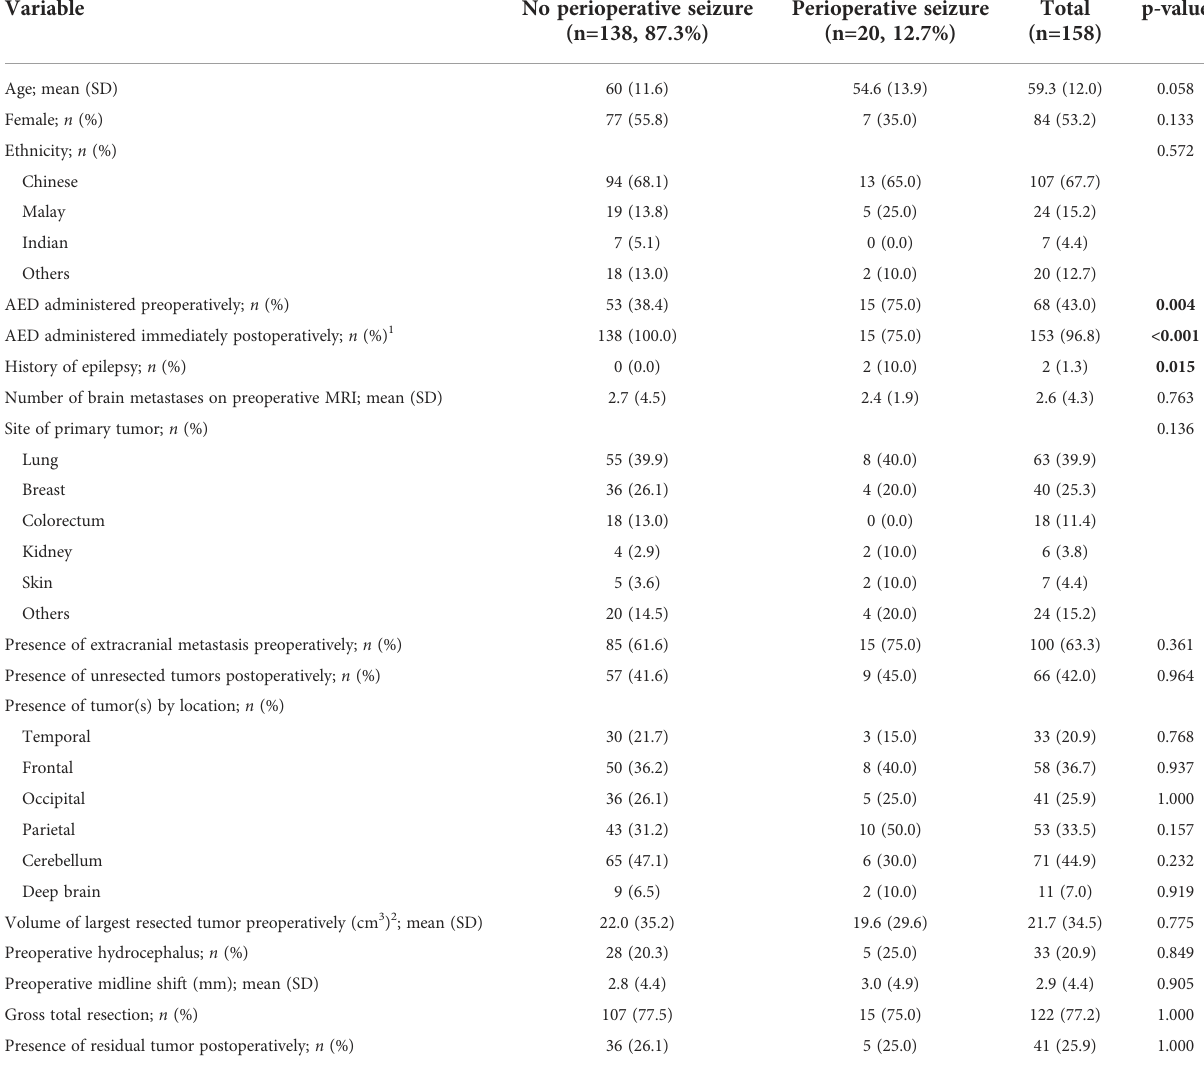
TABLE 1 Baseline characteristics of patients with brain metastases with and without any 30-day perioperative seizure. Variable No perioperative seizure (n=138,